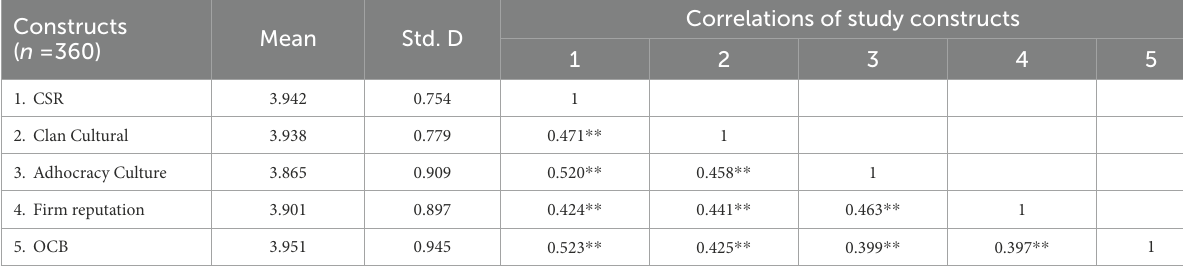
TABLE 2 Descriptive measurements and Pearson correlation of the constructs. Constructs ( n =